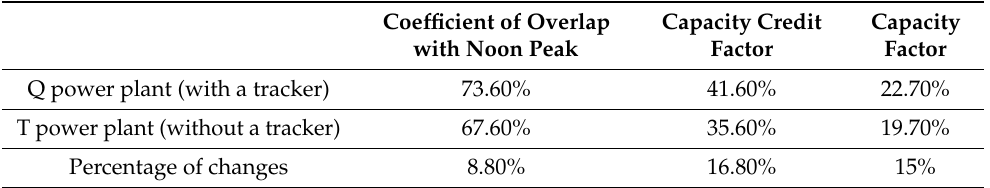
Table 4. Geographical information of two 10 MW power plants in Yazd province. Code of the Power Plant